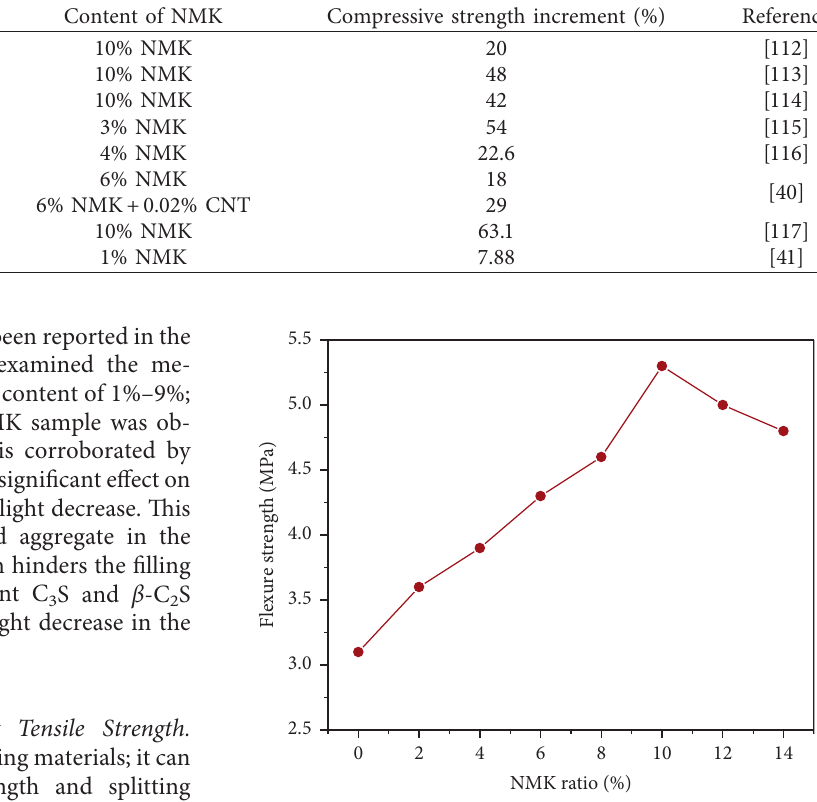
Figure 21: Flexural strength of NMK-modified FRCC as a function of the NMK ratio at 28 days of curing